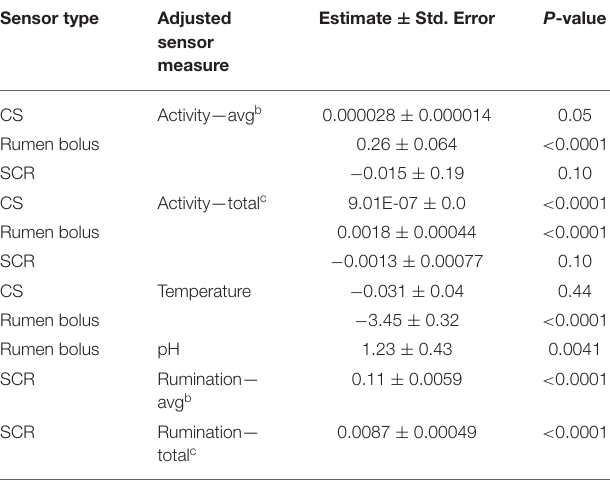
Table 6 . For the CS ear tag, inclusion of all sensor